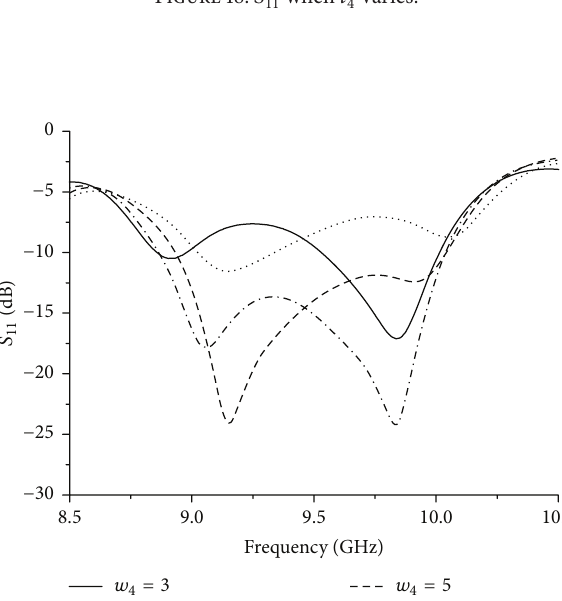
Figure 16: 𝑆 11 when 𝑡 3 varies.